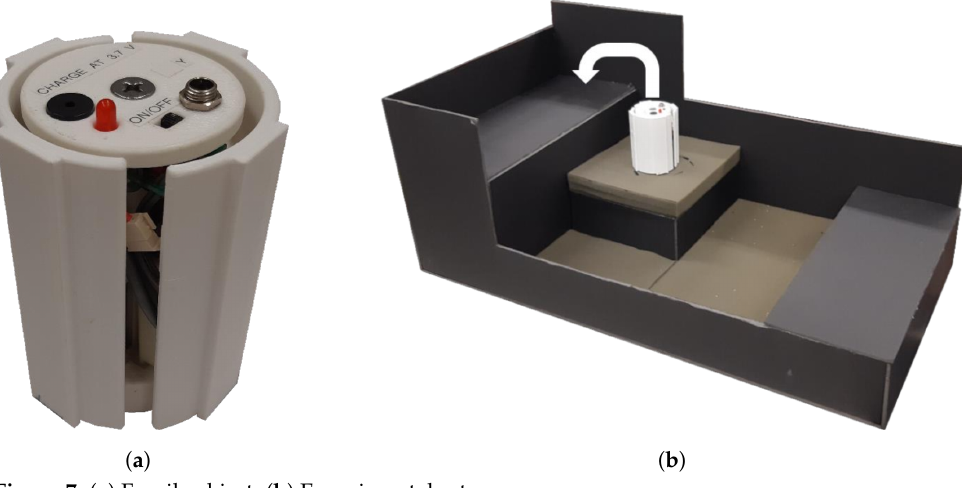
Figure 7. ( a ) Fragile object. ( b ) Experimental